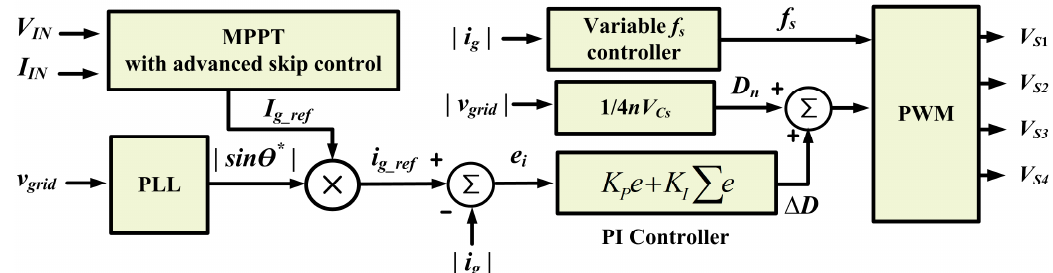
Figure 5. Block diagram of the main controller for the proposed micro-inverter.